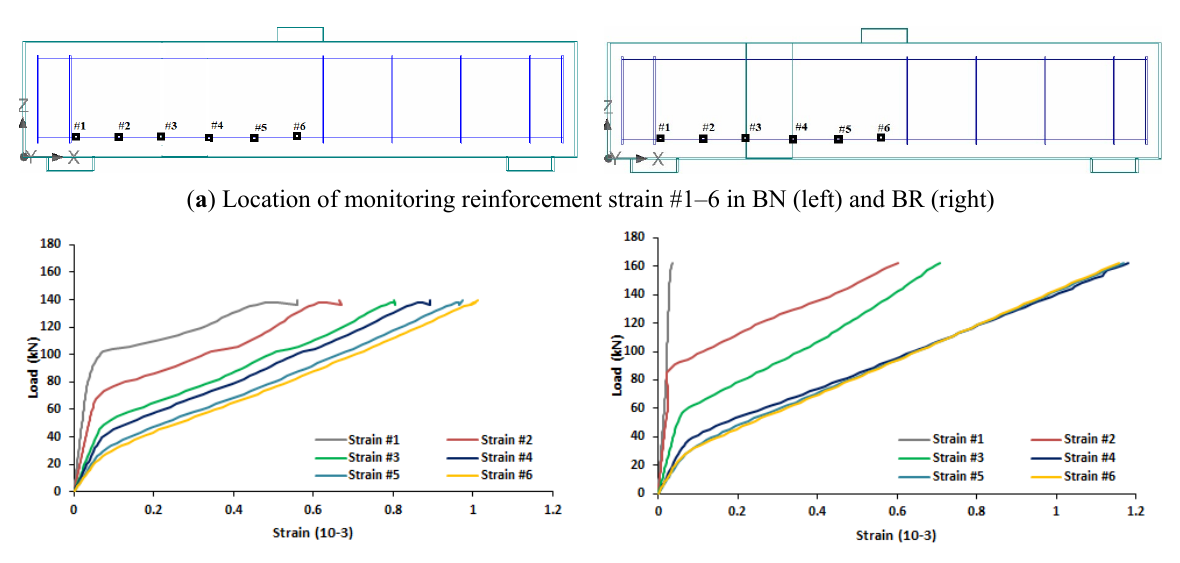
Figure 10. Reinforcement strain ( ϵ xx ) in BN (left) and BR (right) at various stages of loading.